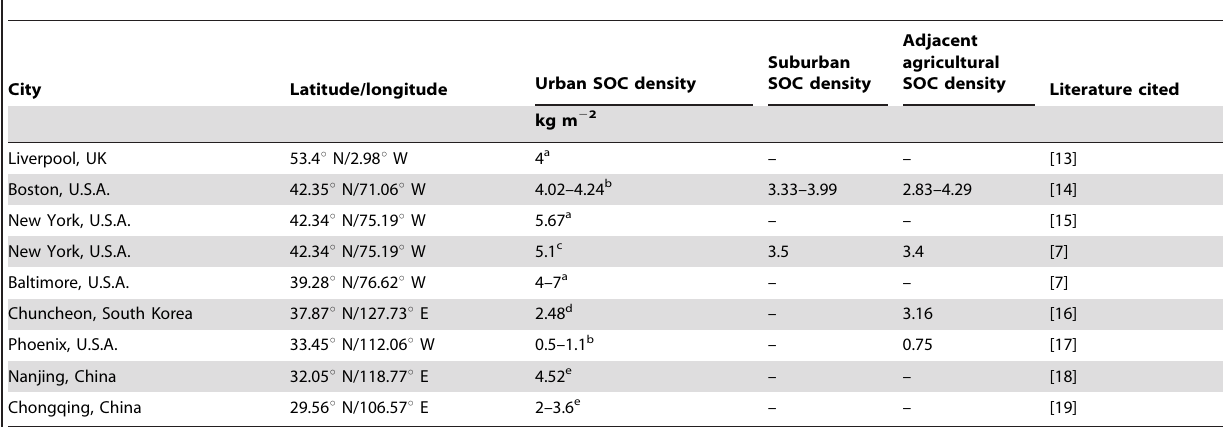
Table 1. Soil organic carbon densities (kg m 2 2 at a depth where indicated) for urban soils located in different